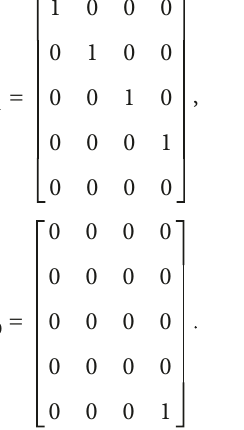
Figure 8: Forced response of the tuned blisk with SSDNC (solid curves: NCMS method; curves with symbol “ × ” : MHBM-AFT) and that without SSDNC (dash curves). Table 2: Comparison of computation time for the tuned blisk with